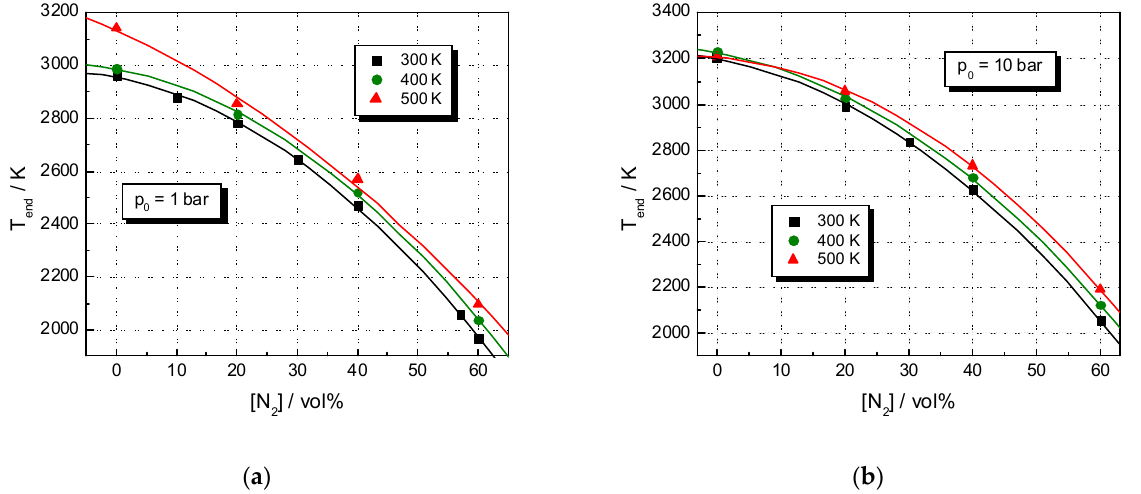
Figure 7. The influence of the added nitrogen on the end flame temperatures of stoichiometric H 2 – N 2 O–N 2 mixtures that were burning under various initial conditions: ( a ) mixtures at 1 bar and various initial temperatures; ( b ) mixtures at 10 bar and various initial temperatures.